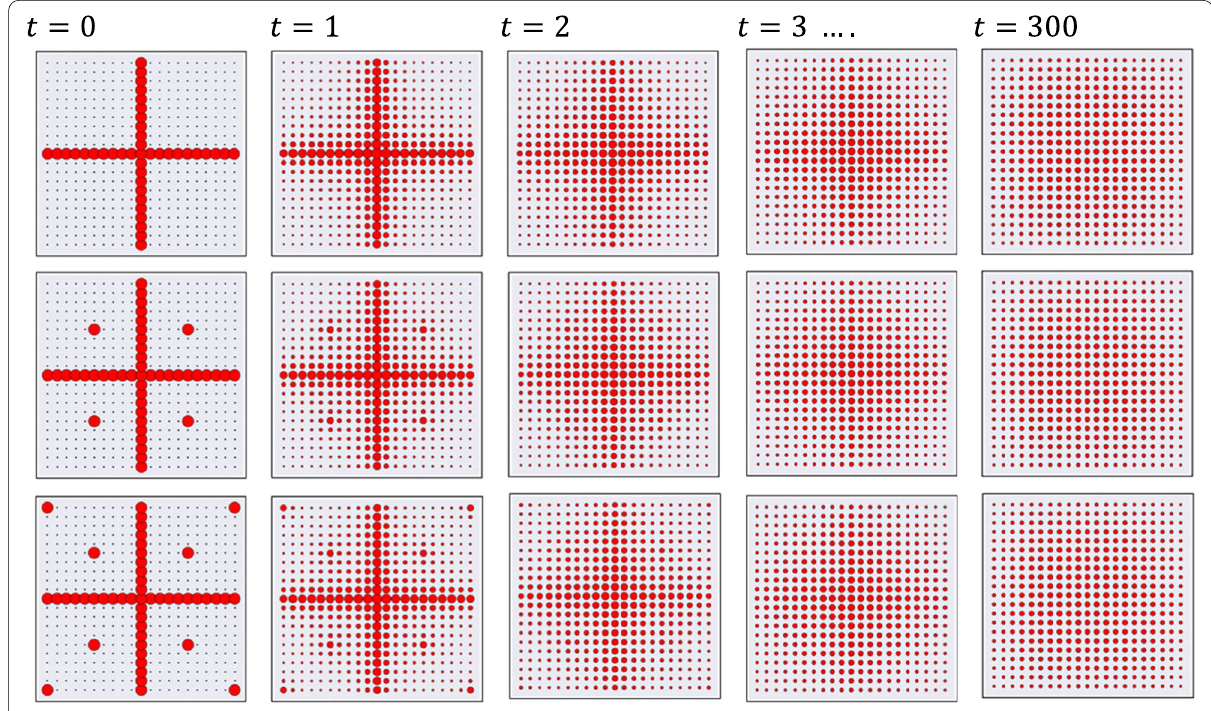
Fig. 11 The Convergence of Configurational Variants of the Linear